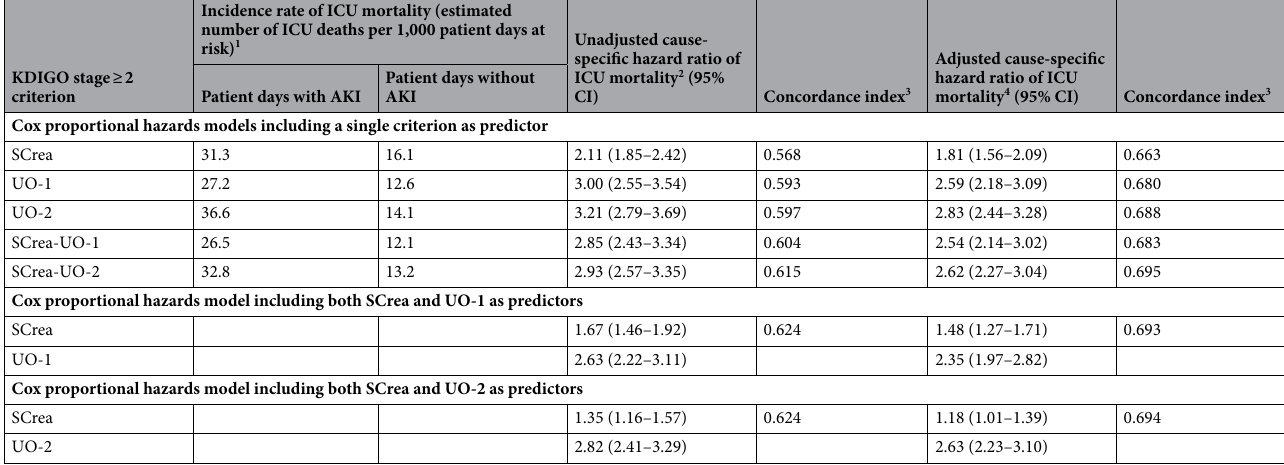
Table 3. Incidence rates and hazard ratios of ICU mortality for AKI stage ≥ 2 vs no AKI stage ≥ 2 across different criteria. 1 Incidence rate ratios only approximate (cause-specific) hazard ratios when the survival distributions in each group both follow an exponential distribution. 2 Estimated by an extended Cox model that treats ICU discharge as a censoring event. 3 Concordance indices are displayed for the corresponding Cox model whose exponentiated coefficient estimates are displayed in the column on the left hand side. 4 Estimated by an extended Cox model that treats ICU discharge as a censoring event that additionally incorporates gender, age (binned into 4 categories according to quartiles) and SOFA score at ICU admission (binned into 4 categories according to quartiles). As a reference: the concordance index for a Cox model including only gender, age and SOFA score at ICU admission (excl. AKI criteria) equalled 0.640. SCrea: serum creatinine > 4.0 mg/dl or > 2 × baseline, where baseline = SCrea-1 whenever available, otherwise SCrea-2, or SCrea-3 (when neither SCrea-1 nor SCrea-2 are available) with Screa-1 defined as baseline Screa measurement as manually entered in ICIS by the treating physician at ICU admission; Screa-2 defined as the lowest